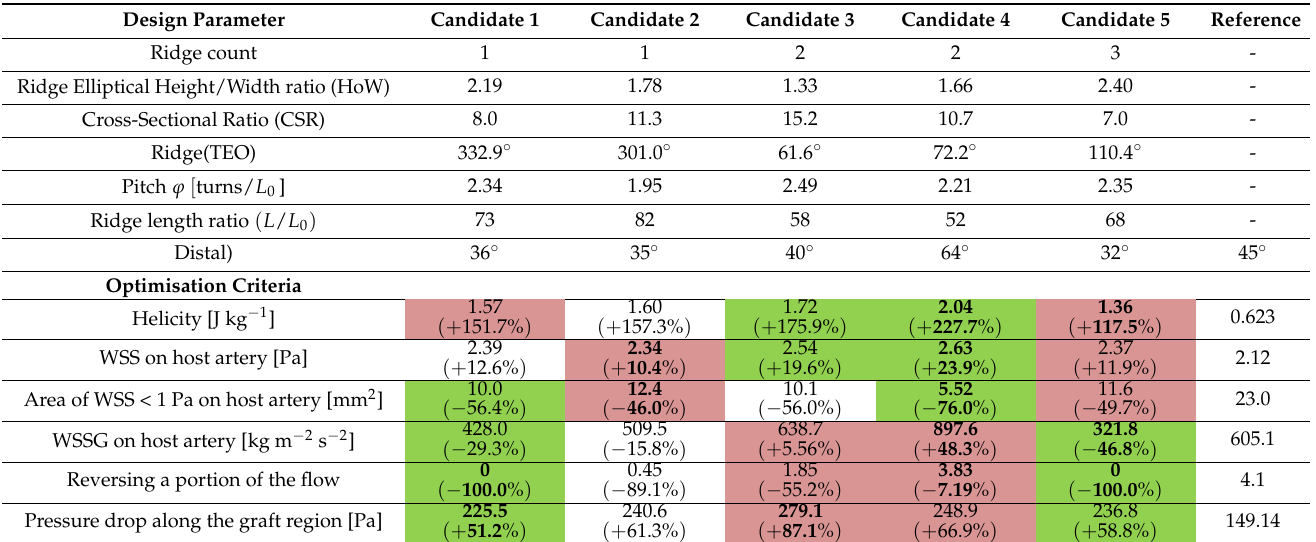
Table 3. Candidate design points and their comparison to a reference solution (with no ridges). Note that (a) green shading and bold is the optimal value, (b) green shading is the second optimal value, (c) red shading and bold is the least optimal value, and (d) red shading is the second least optimal value. The difference from the reference solution is shown in the